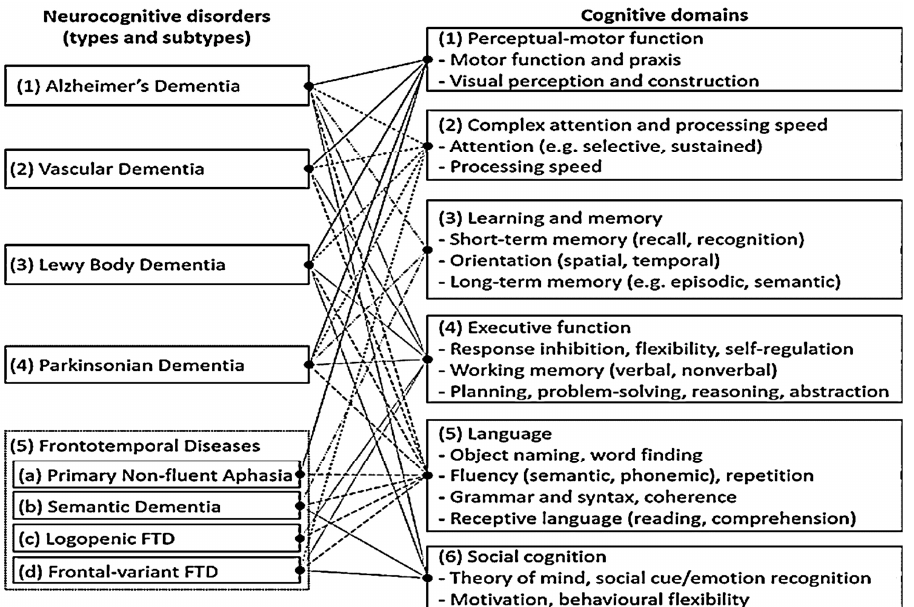
Figure 1. Different types of neurocognitive disorders and associated deficits in various cognitive domains. Links to different cognitive domains are distinguished by different types of lines. The figure is adapted from Lay et al. (under review) [3].